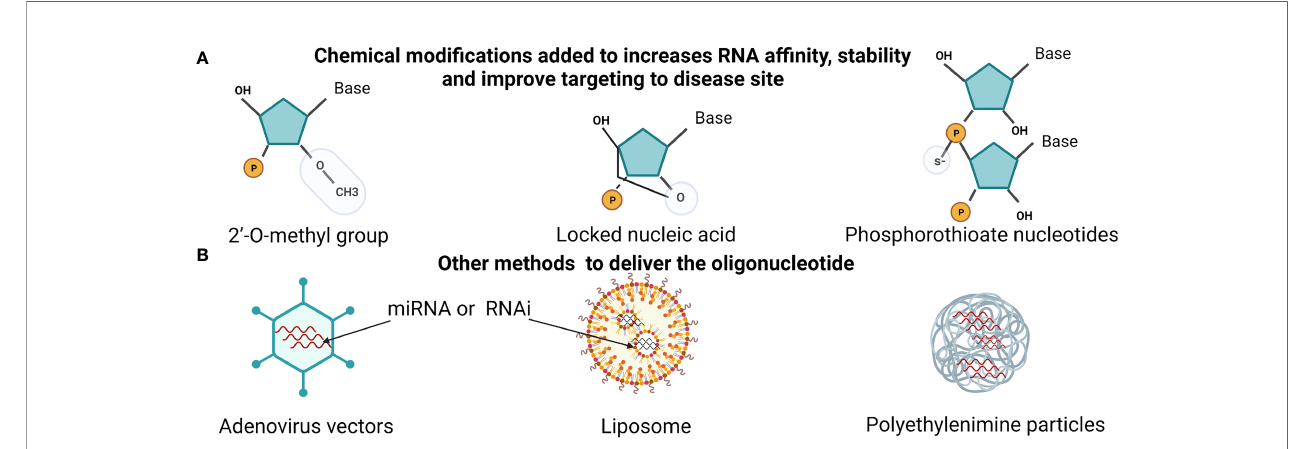
FIGURE 2 | miRNA therapeutics and delivery methods. (A) showing the chemically modi fi ed oligonucleotide to sustain RNA stability. Such as, adding 2 ’ - O -methyl group, linking the 2 ′ - O atom and the 4 ′ -C, or adding sulfur to phosphate group (phosphorothioate). (B) Methods that are used to increases RNA delivery (miRNA or RNAi). Using adenovirus, liposomes vehicles and synthetic polyethylenimine. Created with